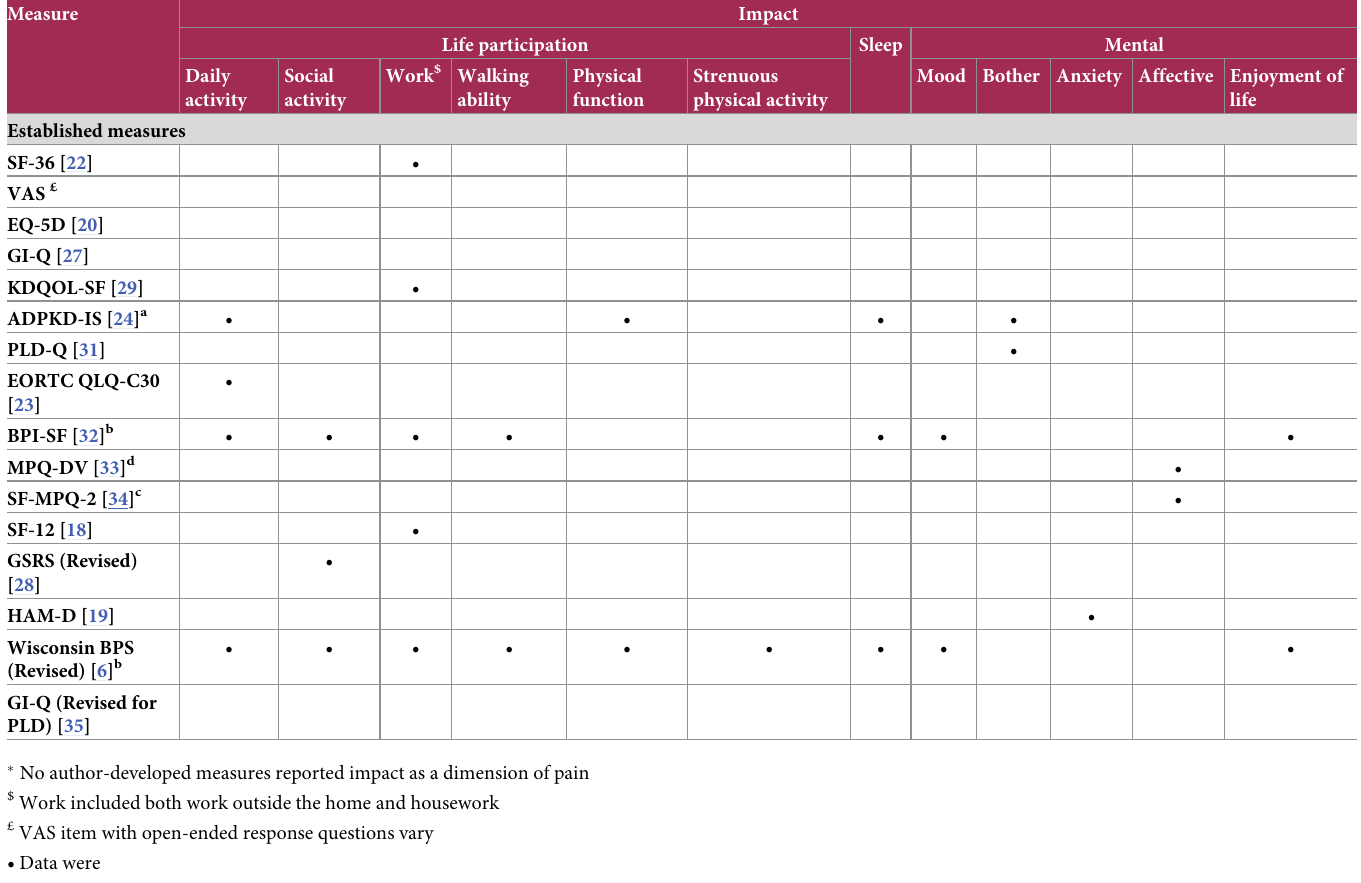
Table 4. Dimensions of pain assessed by measures: Impact of pain � .